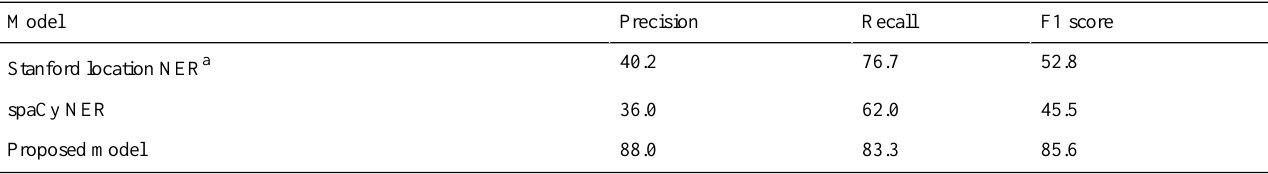
Table 3. Comparison of our model to two other general-purpose baselines in the task of identifying past affirmed travel locations.